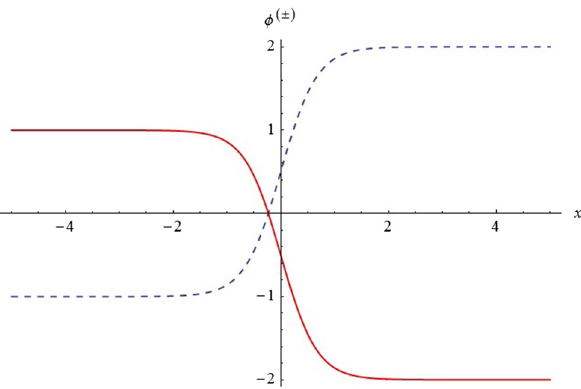
Fig. 1 Thesolid(red)lineistheplotofthe φ ( + ) solutionfortheparam- eter values a 1 = 3 and a 2 = − 1. The dashed (blue) line is the plot of the φ ( − ) solution for the parameter values a 1 = − 1 and a 2 = 1. In both cases, we have chosen α = 1, and then E BPS = 9 /